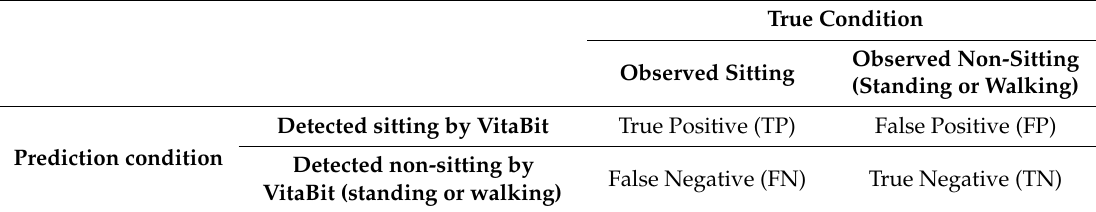
Table 1. Confusion matrix for the example of sitting compared to direct